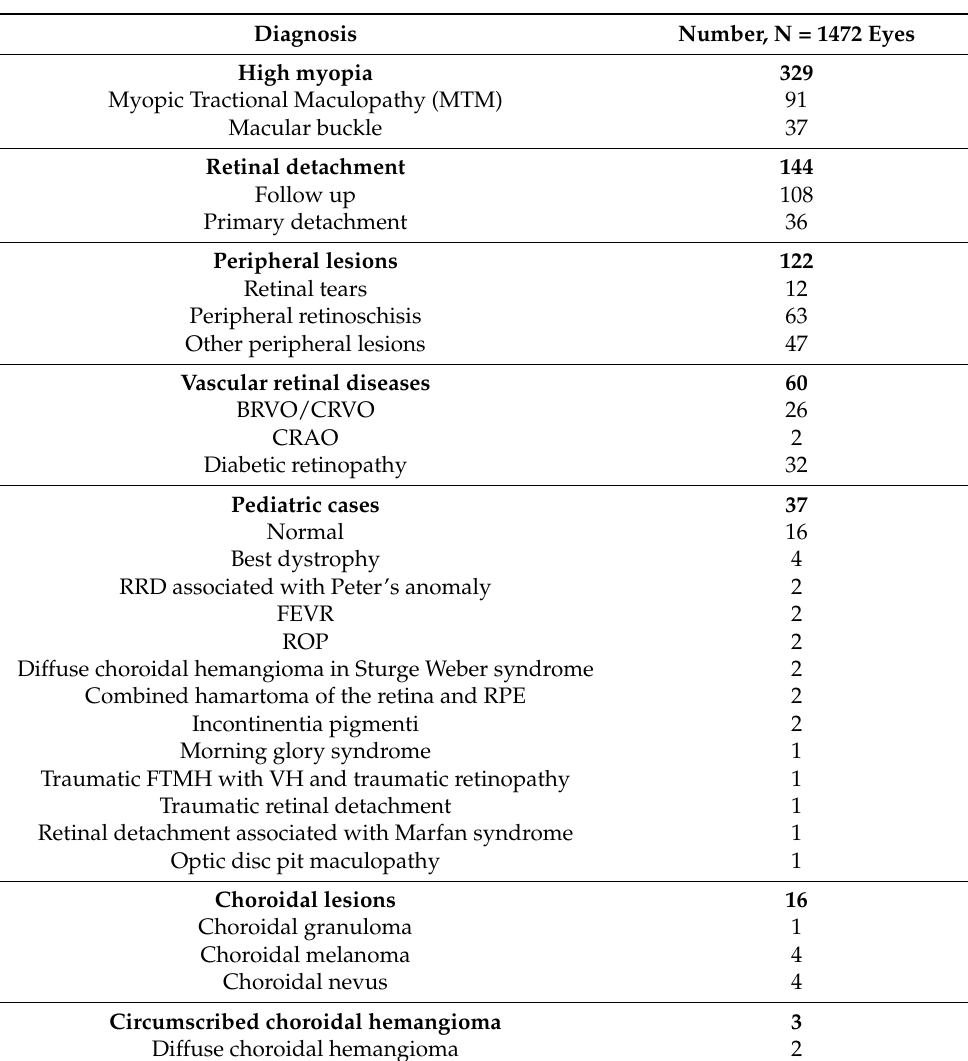
Table 2. Diagnosis